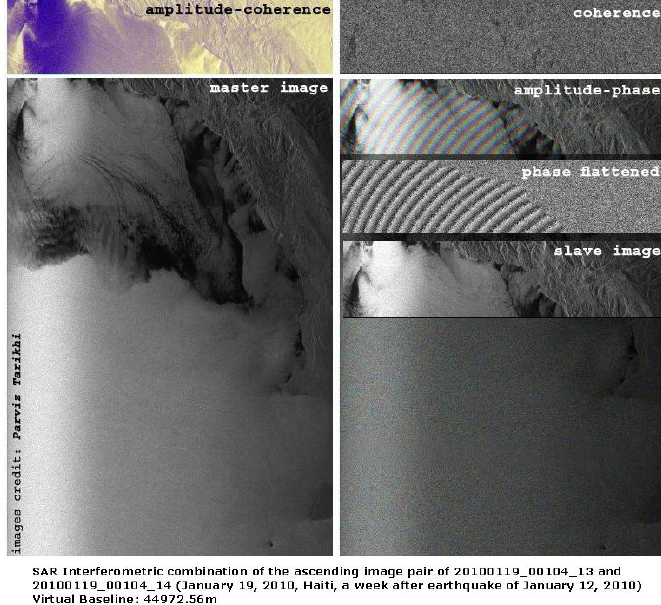
Figure 8: Liqui-InSAR for South-Western Haiti coastal